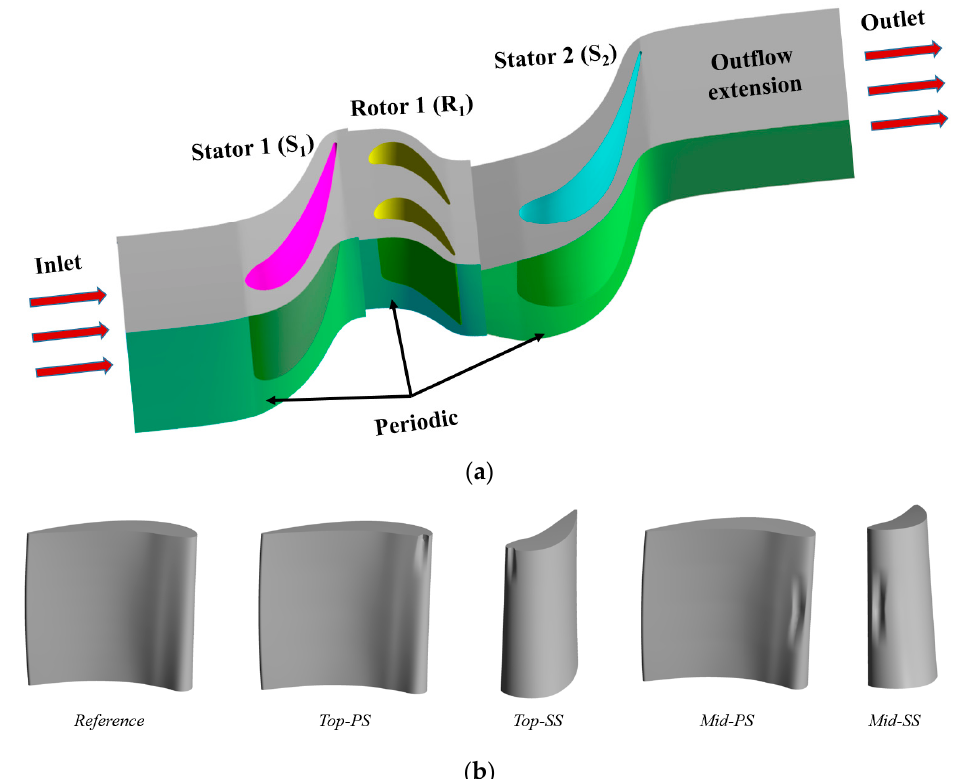
Figure 1. ( a ) Computational model used in this study; ( b ) Different types of damaged rotor blades (top and mid denote near-tip and near-midspan regions of rotor blade, respectively, whereas PS and SS denote the pressure and suction sides, respectively). Similar figure can be found in [5].